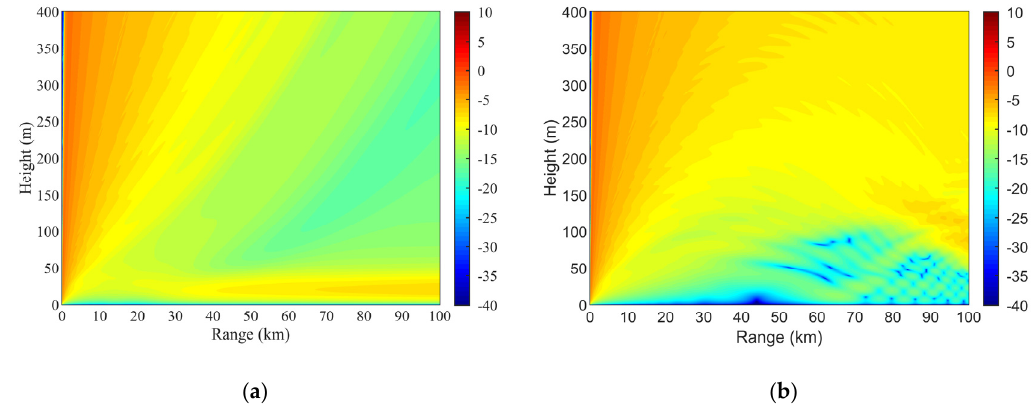
Figure 5. Pattern propagation factors (dB) in horizontally homogeneous surface ducts for ocean-scattered B1I signals: ( a ) surface duct without a base layer; and ( b ) surface duct with a base layer.